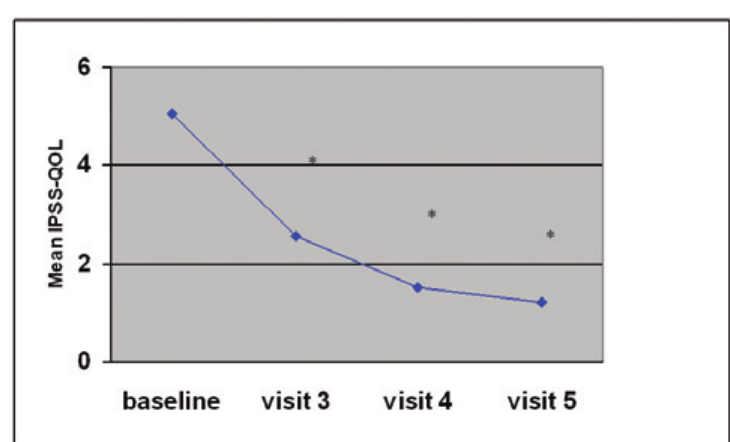
Figure 3 - Improvement in IPSS-QoL.